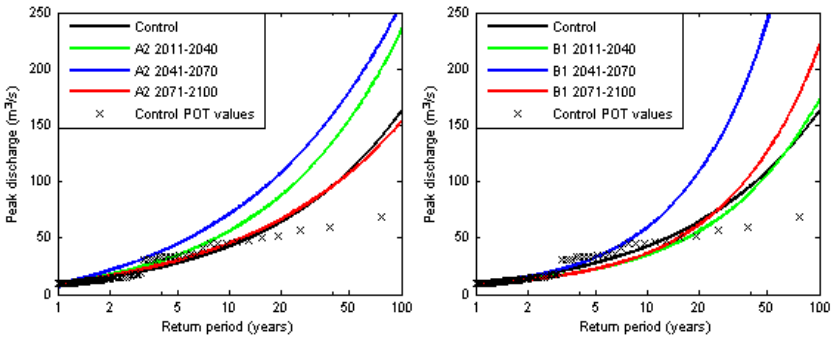
Figure 10 GP distribution fitted to the POT discharge values of the Anoia sub-basin for the control (1980–2008) and future periods for the A2 (left) and B1 (right) scenarios. 3